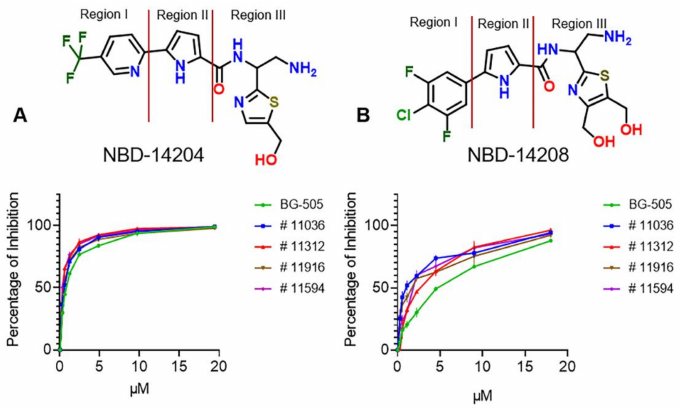
Figure 1. Chemical structures with region location and representative dose-response curves of NBD-14204 ( A ) and NBD-14208 ( B ) against five Env-pseudotyped clinical